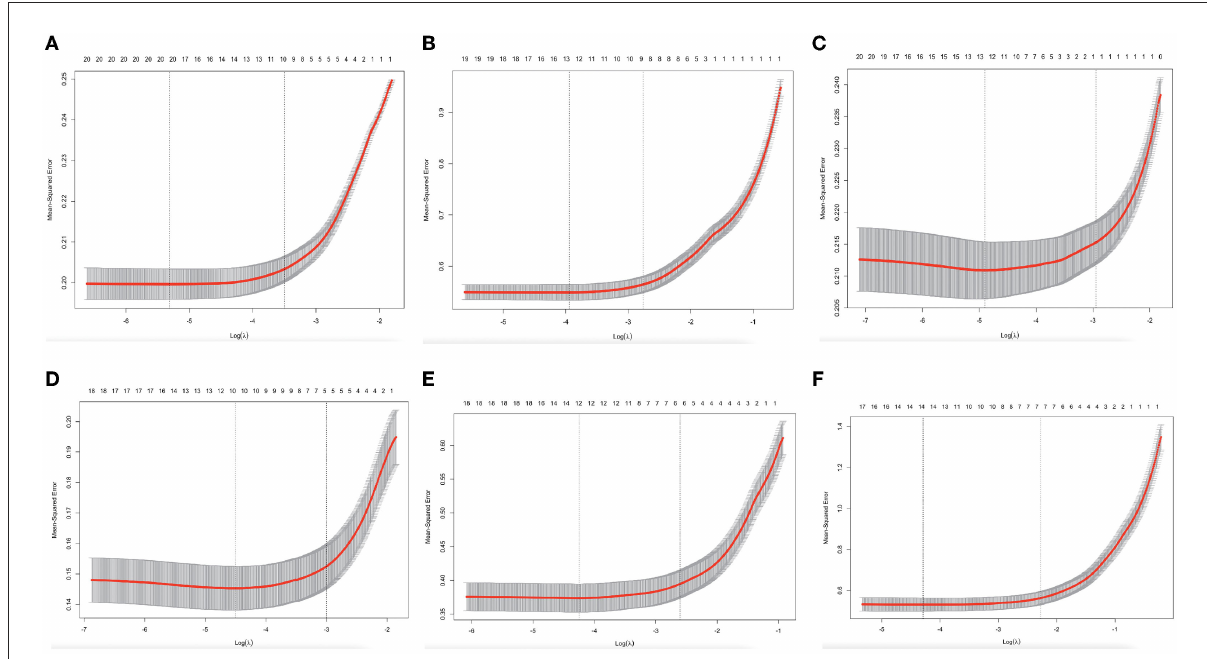
FIGURE4 Predictors’ selection using Lasso regression. (A–F) Identification of the optimal penalization coefficient λ in the Lasso model with 10-fold cross-validation and the minimum